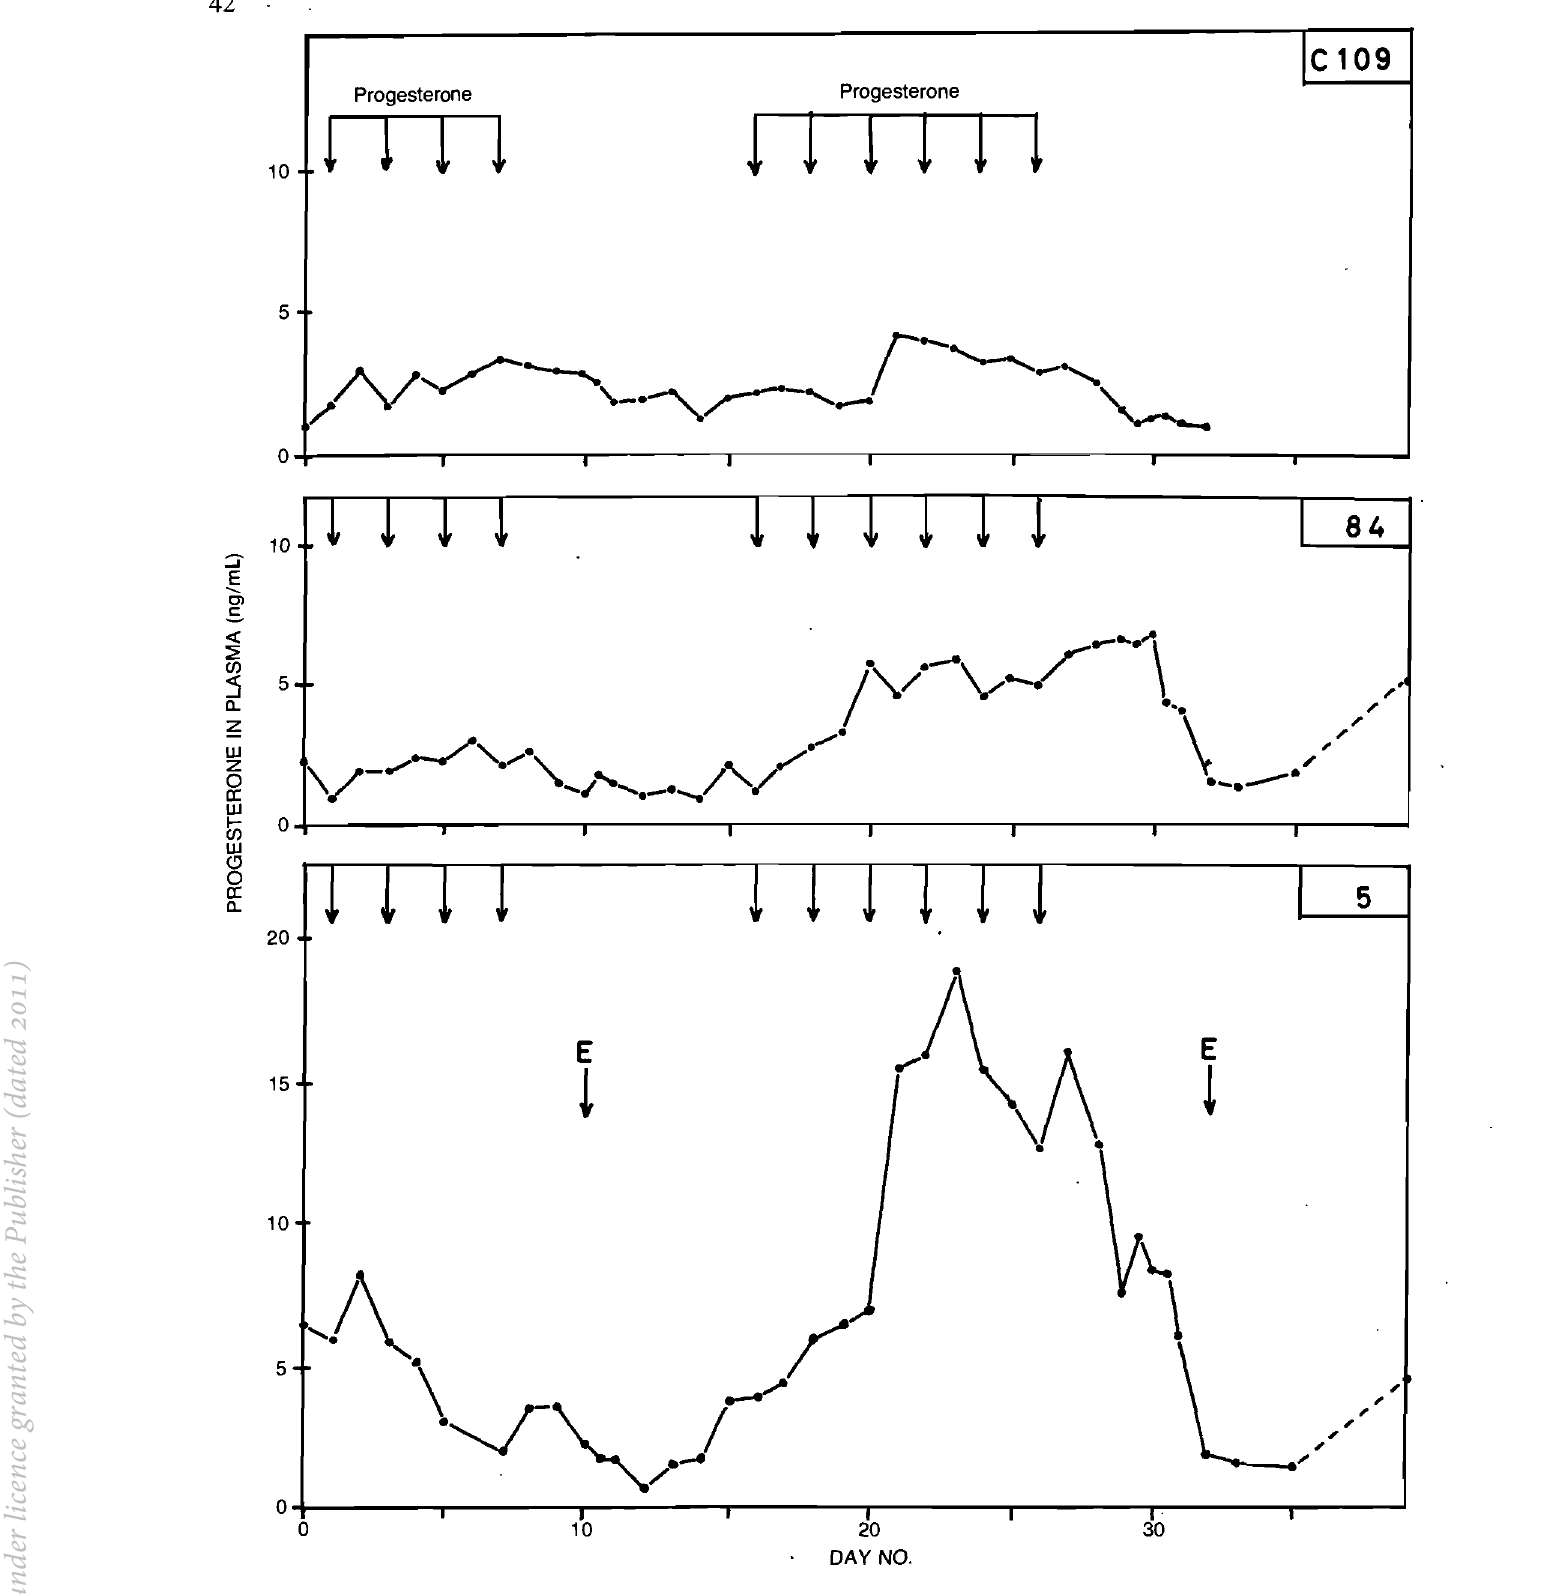
Fig. 3. Progesterone levels in the plasma of Cow C1 09 and heifers 84 and 5 during and after progesterone treatment (E =